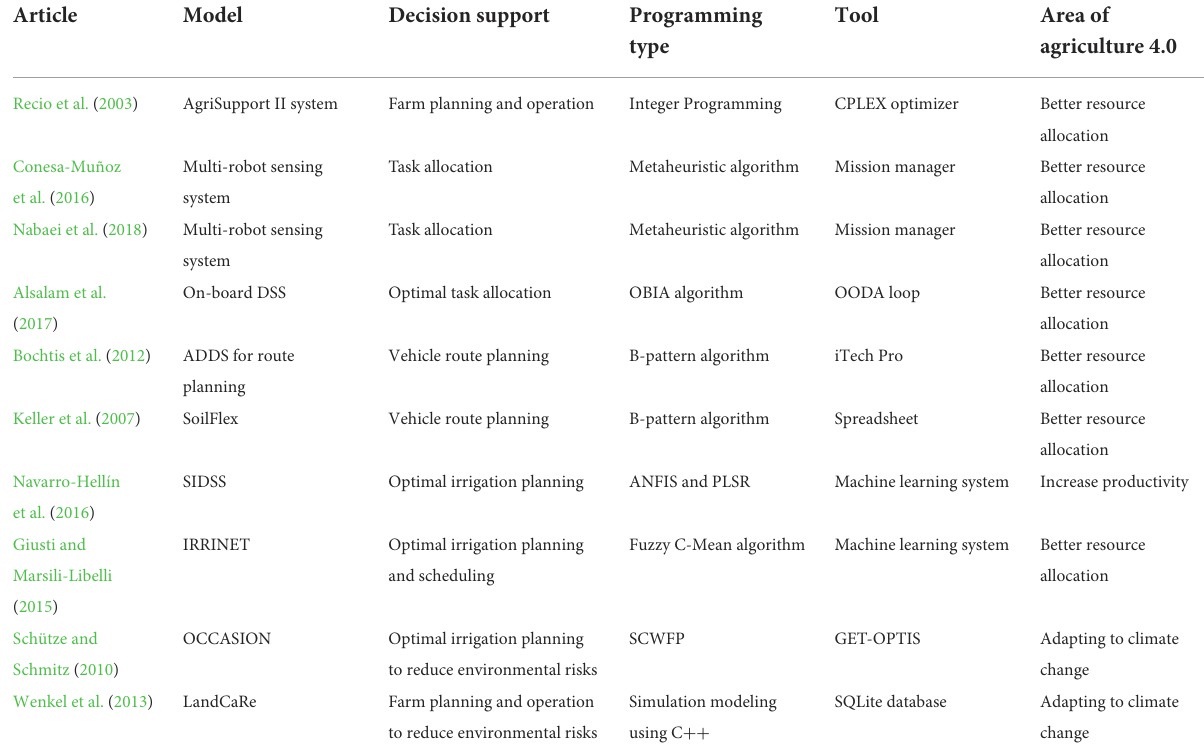
TABLE 12 Research stream: applications of DSS in smart